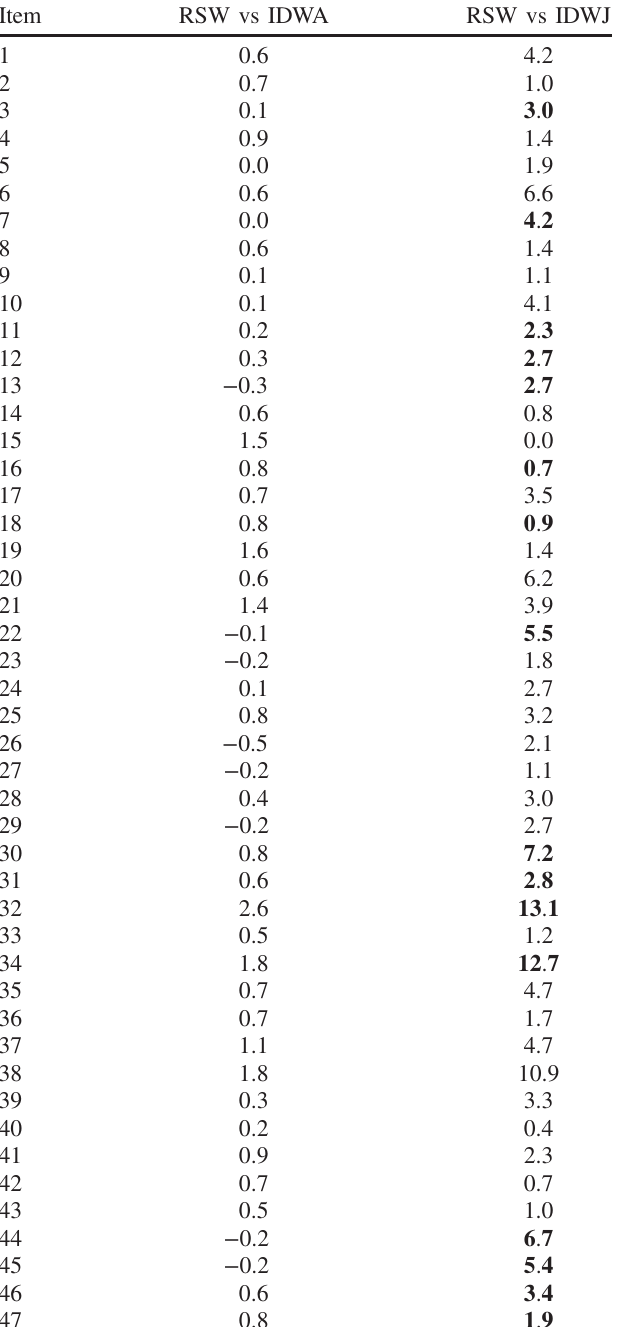
TABLE II. The dot product effect size values for all compar- isons between our RSW dataset, and the IDW American and Japanese datasets. Bolded entries indicate items that were high- lighted by IDW as being particularly different between their American and Japanese